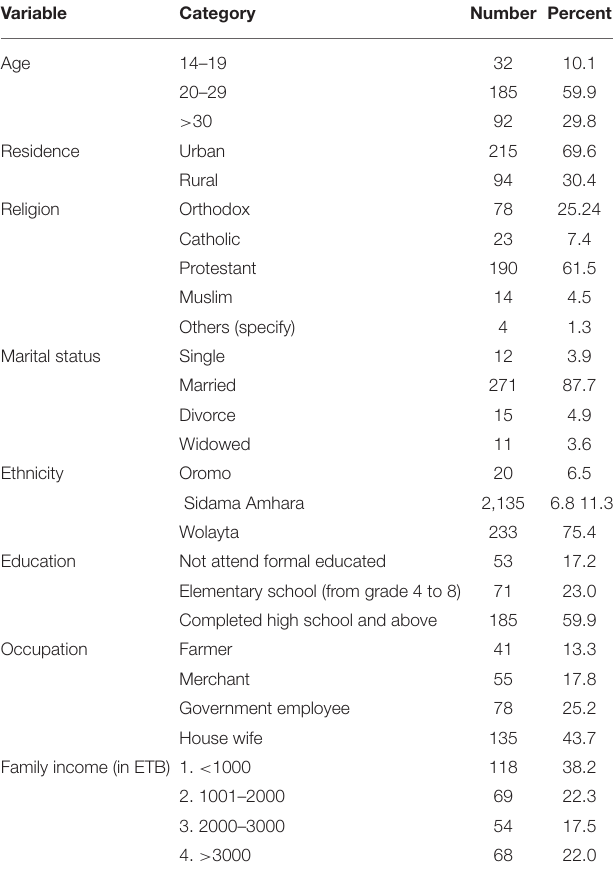
TABLE 1 | Socio demographic characteristics of pregnant women who were at antenatal care service and participated in study at Wolayta Sodo teaching and referral Hospital, June,